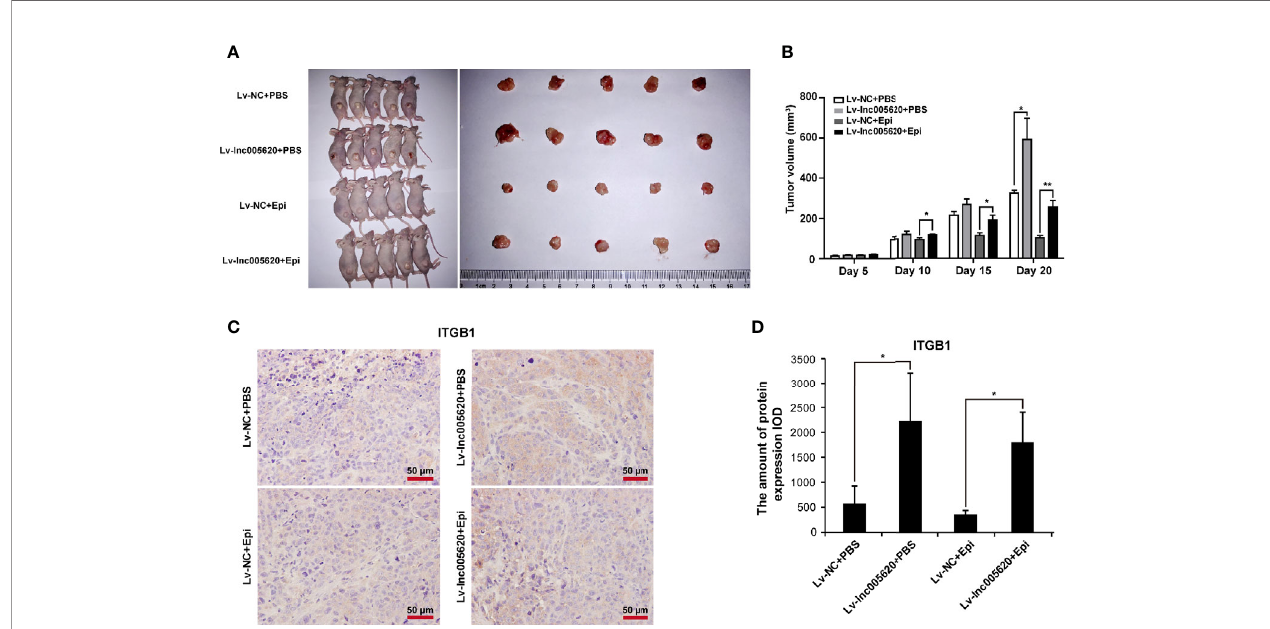
FIGURE 7 | lnc005620 facilitates tumorigenesis and epirubicin resistance in vivo . MDA-MB-231 native cells stably transfected with Lv ‐ lnc005620 or negative control Lv ‐ NC were injected into mouse fl anks. After the tumors were established, mice were treated with 5 mg/kg epirubicin or PBS subcutaneously at the tumor sites weekly for 2 weeks. (A) Images of nude mice and tumors. (B) Volumes of tumors. (C) Immunohistochemistry analysis of ITGB1 expression in the tumors. Scale bars: 50 m m. (D) Quantitative analysis of ITGB1 expression. n = 5/group. Data are represented as the mean ± SD, * P < 0.05, ** P <